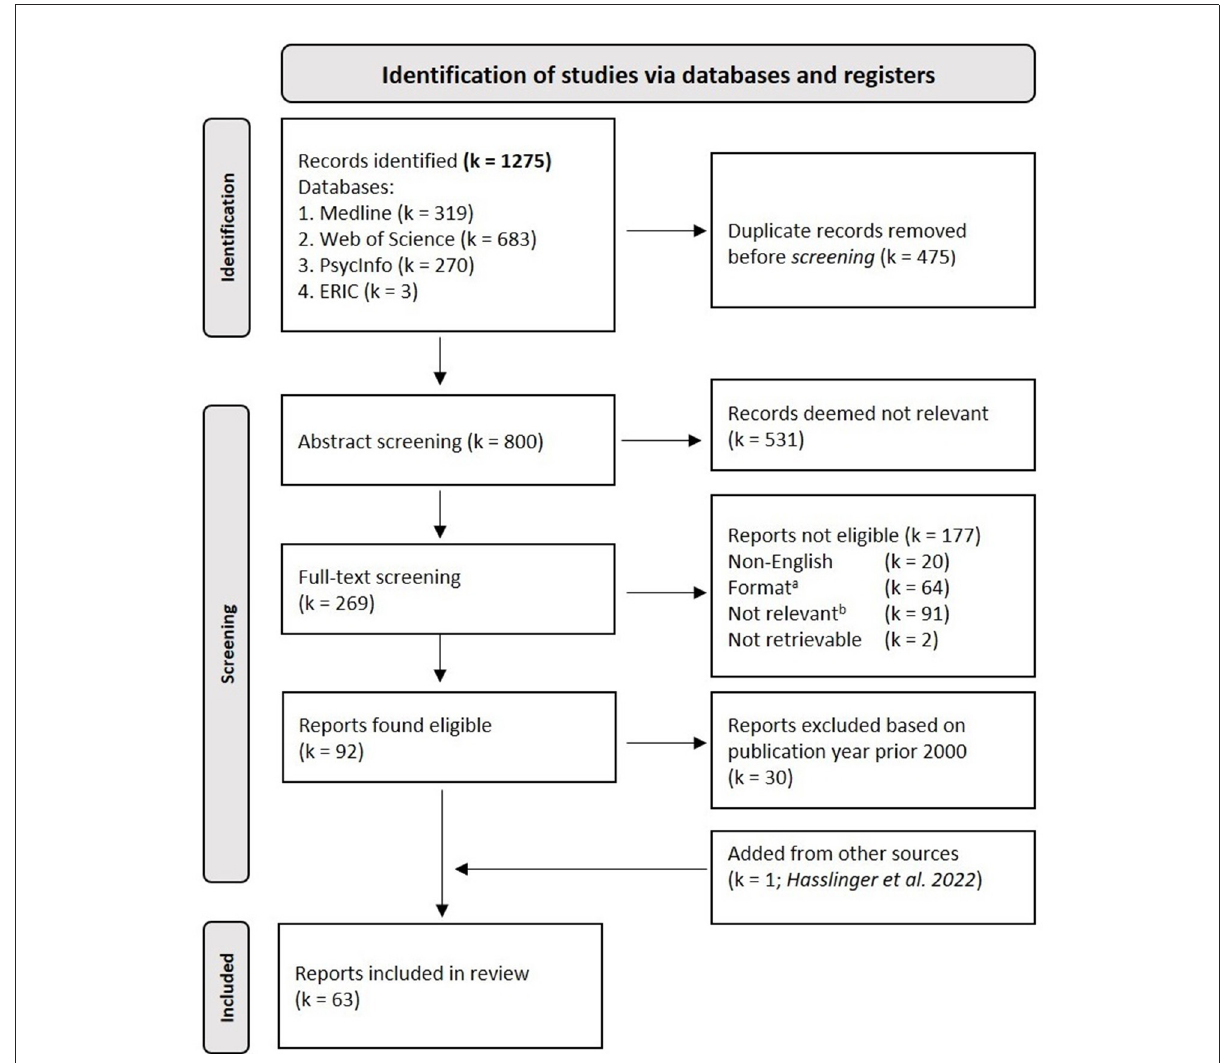
FIGURE1 PRISMA flow-diagram. a e.g., Conference abstracts, Books and Book-chapters; b e.g., Reviews, Editorials and Non-relevant